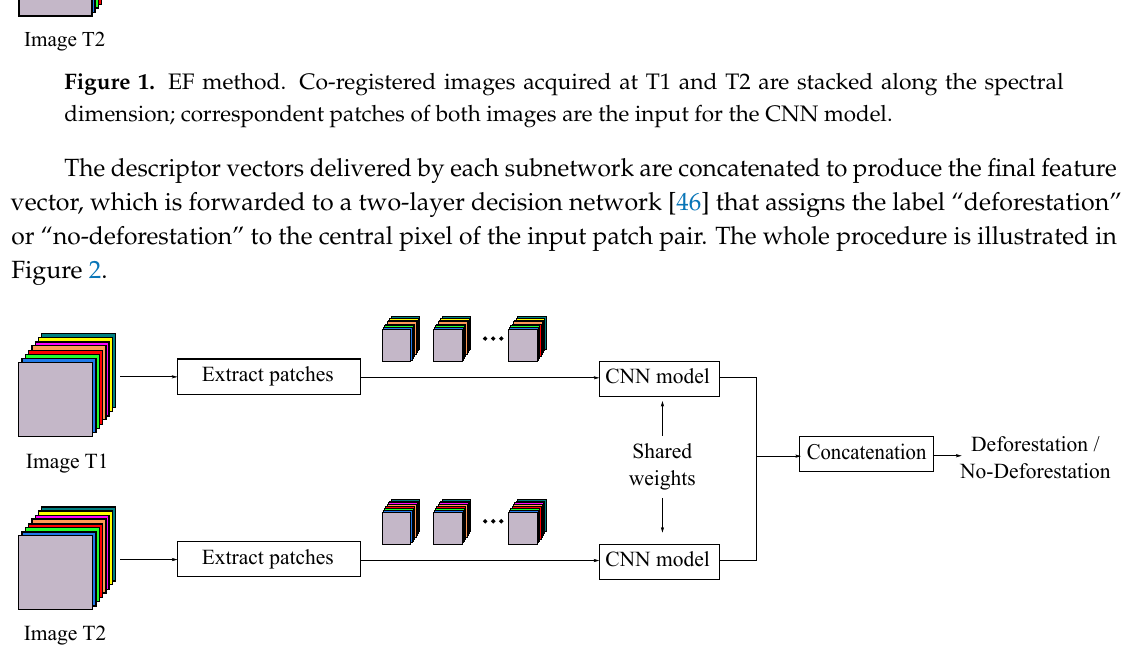
Figure 2. SN method. Correspondent patches cropped from two co-registered images acquired at T1 and T2 are the inputs for two CNN networks, both sharing the same architecture and parameter